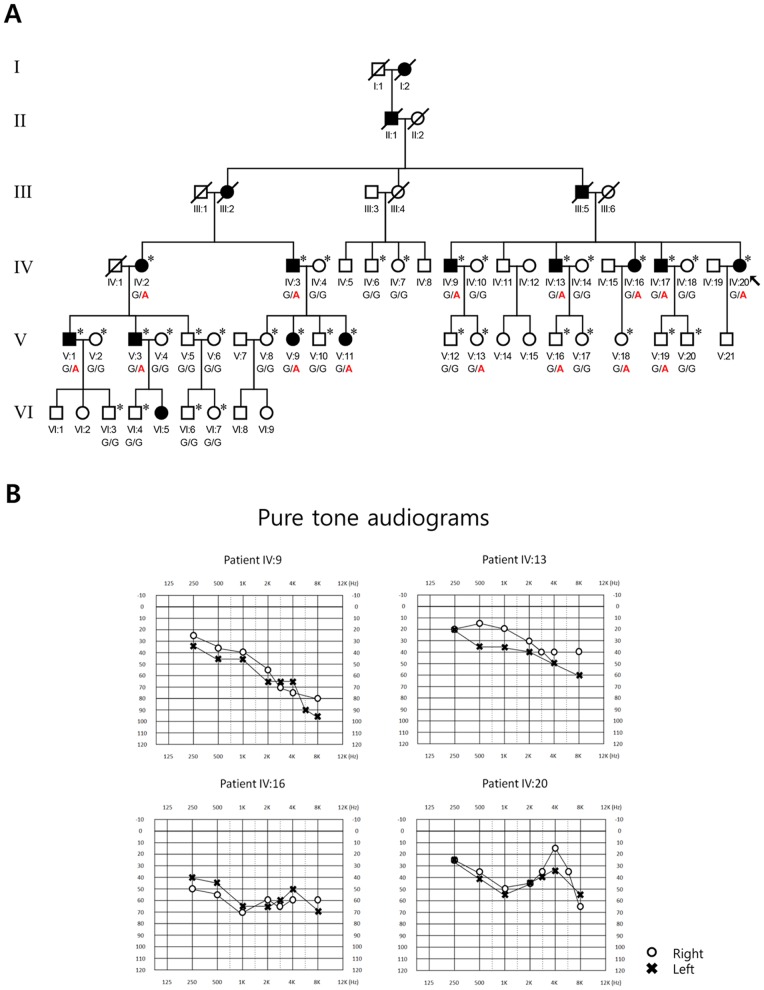
A large Korean family with autosomal dominant late-onset nonsyndromic hearing loss.(A) The pedigree with the proband (IV-20) indicated by an arrow. Individuals who participated in the molecular genetic diagnosis are marked with an asterisk on the right shoulder of symbols. Whole exome sequencing was performed in 4 individuals (IV:3, IV:17, V:1 and V:5). The genotypes at theArg326Lys mutation site of POU4F3are presented for each individual (mutant allele “A” in red). (B) Audiograms of 4 affected individuals in the family including the proband.